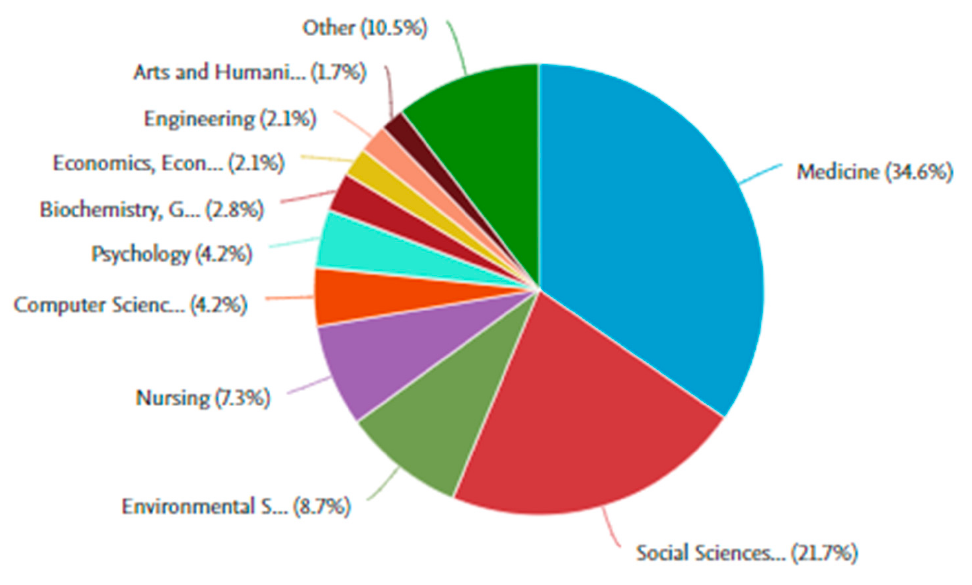
Figure 6. Publications by scientific area—Scopus.